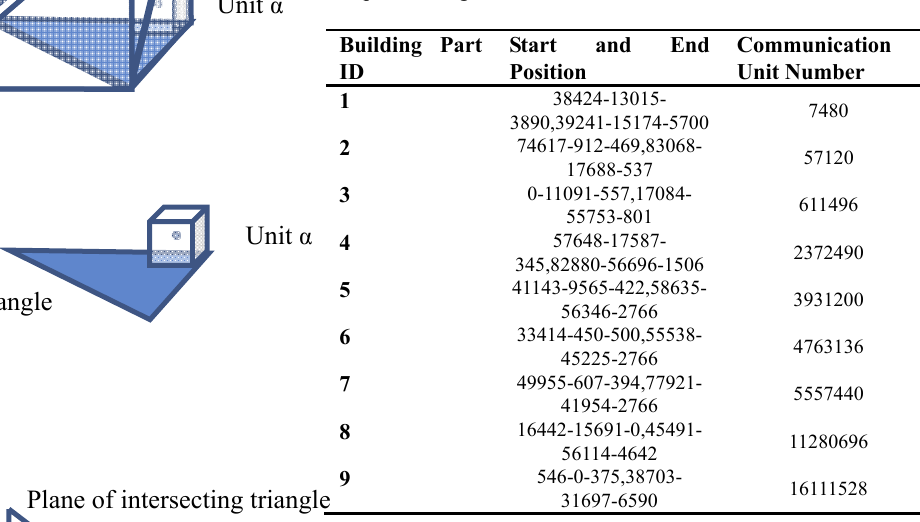
Table 1. The Extraction Result of the Experiment Area